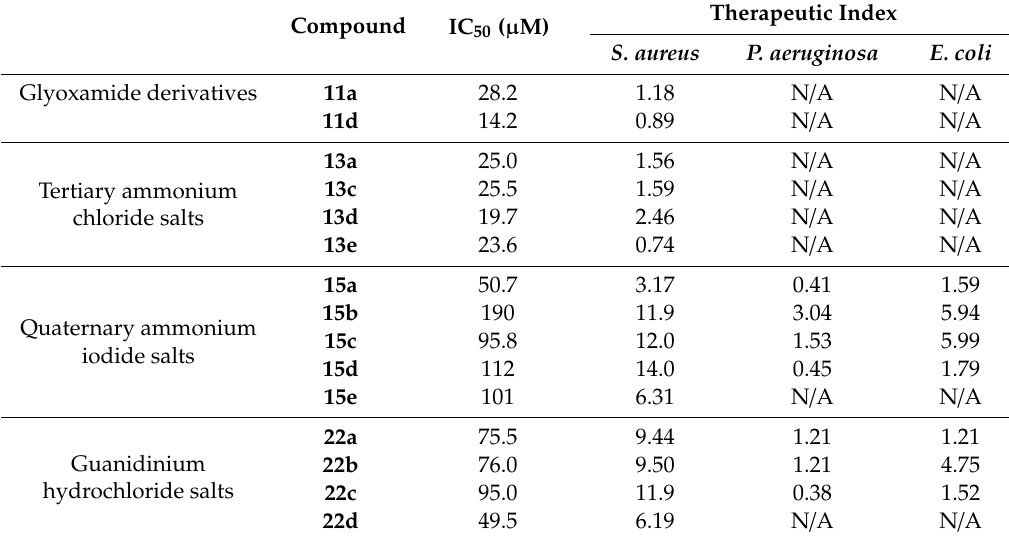
Table 2. IC 50 value of compounds against MRC-5 normal human lung fibroblasts and their therapeutic indices with respect to di ff erent strains of bacteria.